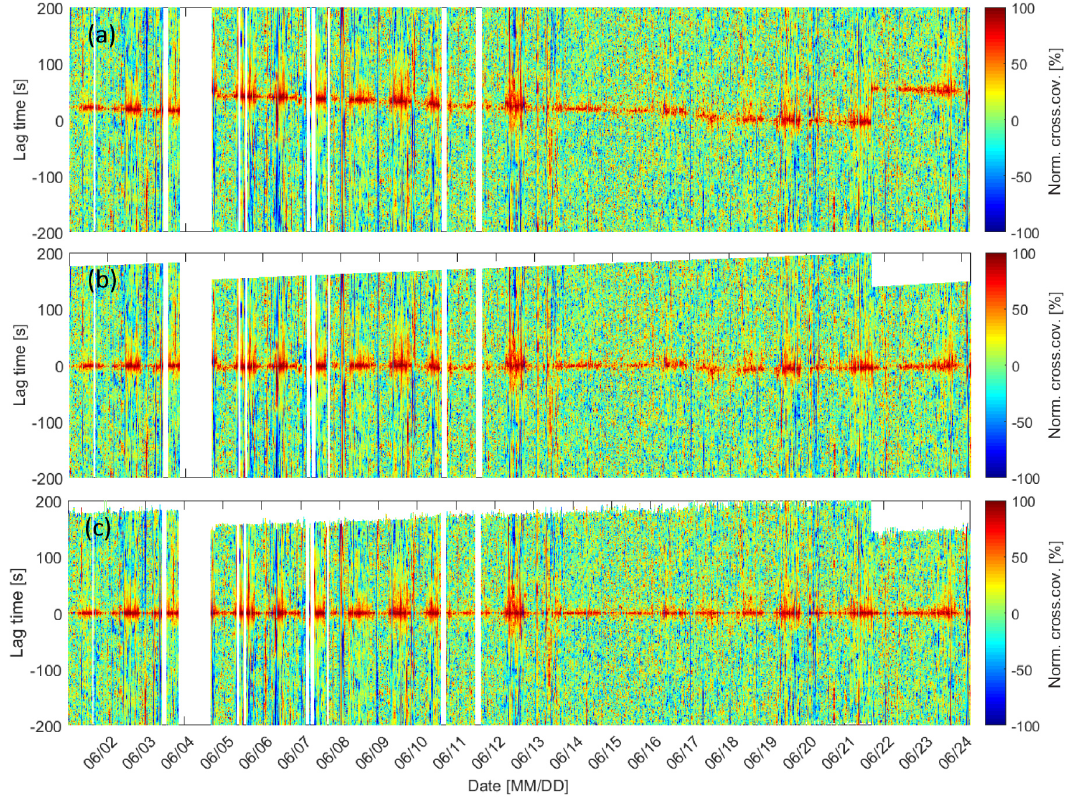
Figure 1. (a) Normalized cross-covariance functions (CCFs) for monoterpene measurements in June, without time shift correction. The shift between the two computer clocks is clearly visible. (b) CCFs after correcting for lag time shifts. (c) The CCFs of monoterpenes after the final lag time correction. In the final (third) step, the smoothed maximum of the CCF function (see Fig. 2) was sought for each compound and 30min data individually, in a ± 10s window of the previous lag time (step 1 and 2).